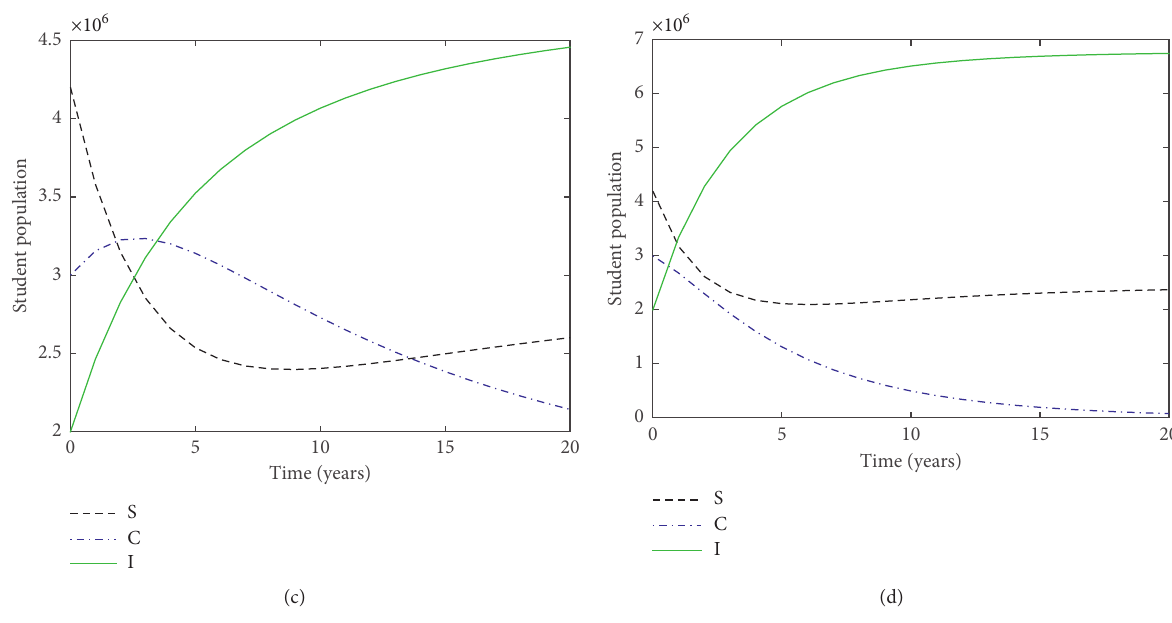
Figure 3: Simulation of the model showing the total number of Susceptible, Morally corrupt, and Immune as a function of time using initial conditions given in Section 2. Parameters used are in Table 2 with (a) σ � 0, α � 0, R